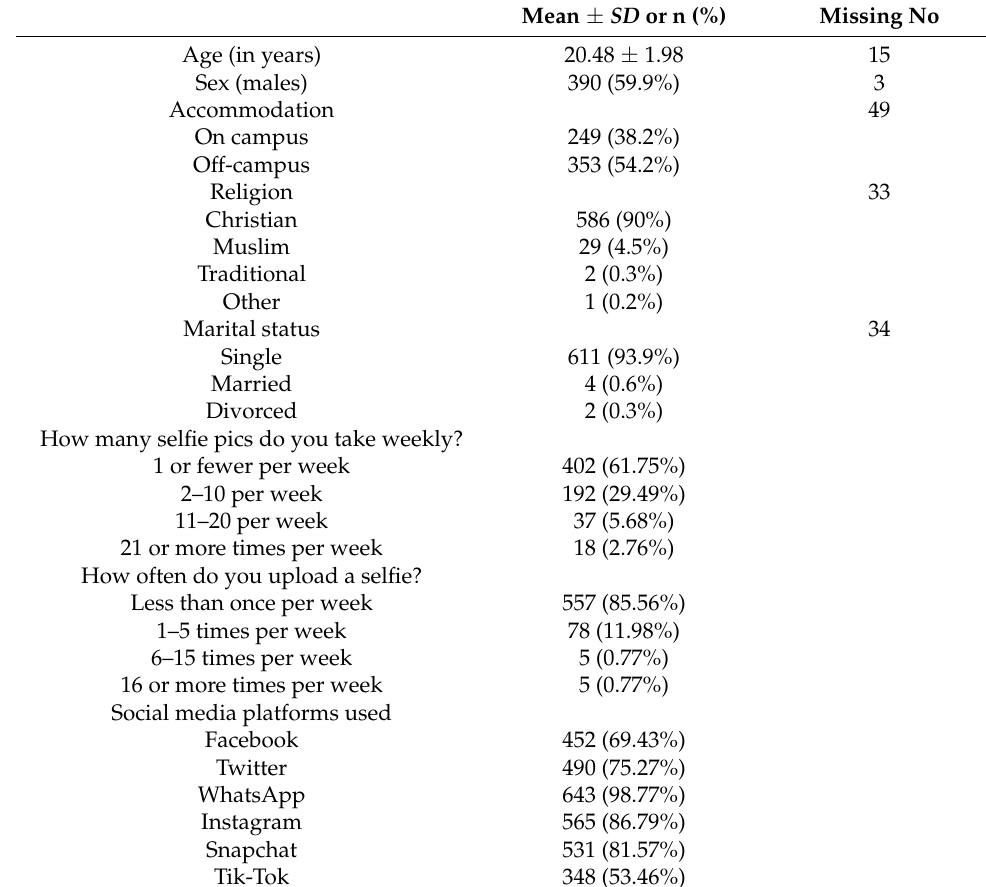
Table 1. Sociodemographic characteristics of participants ( N =